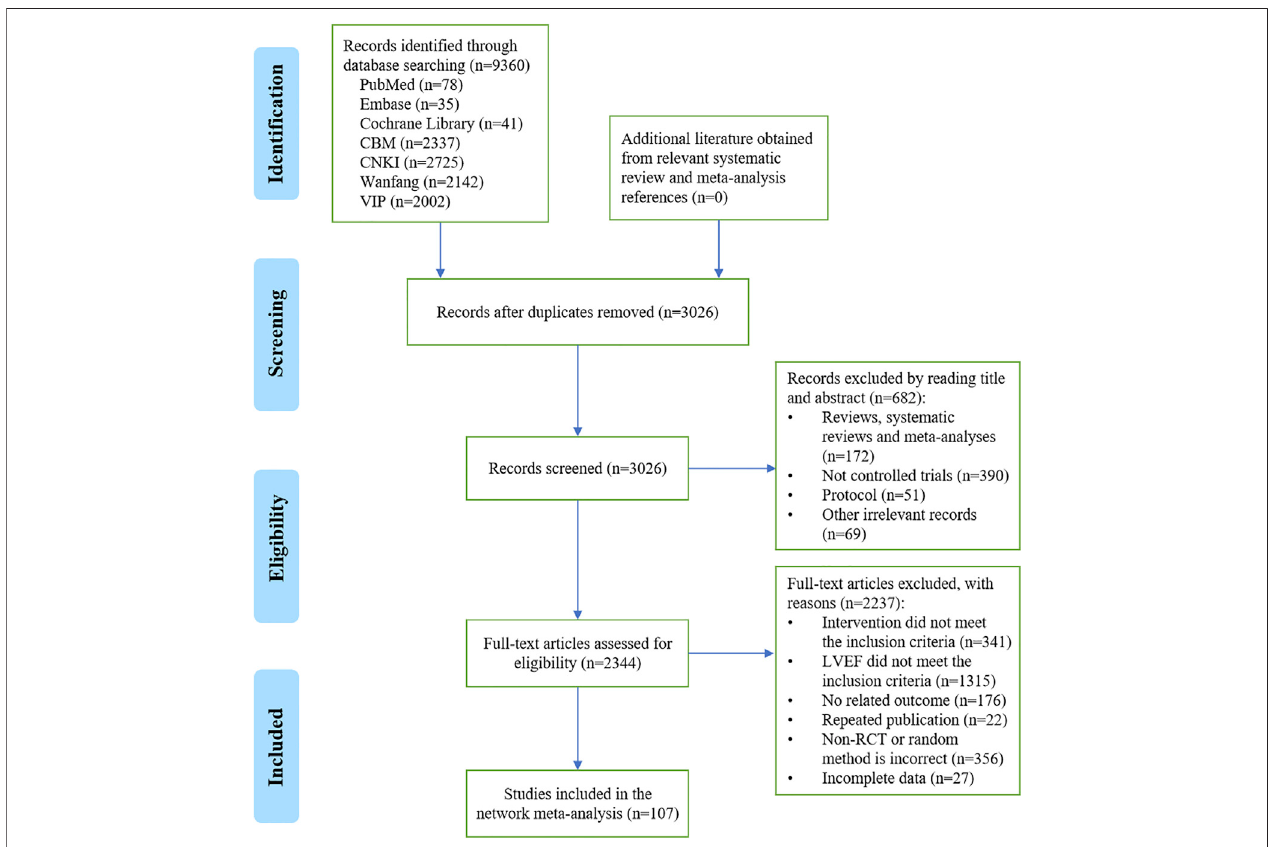
FIGURE1| Flowchartoftheliteraturescreeningprocess.CBM,ChineseBioMedicalLiteratureDatabase;CNKI,ChinaNationalKnowledgeInfrastructure;VIP,VIP Chinese Science and Technology Journal Database; LVEF, left ventricular ejection fraction; RCT, randomized controlled trial; n , the number of articles.